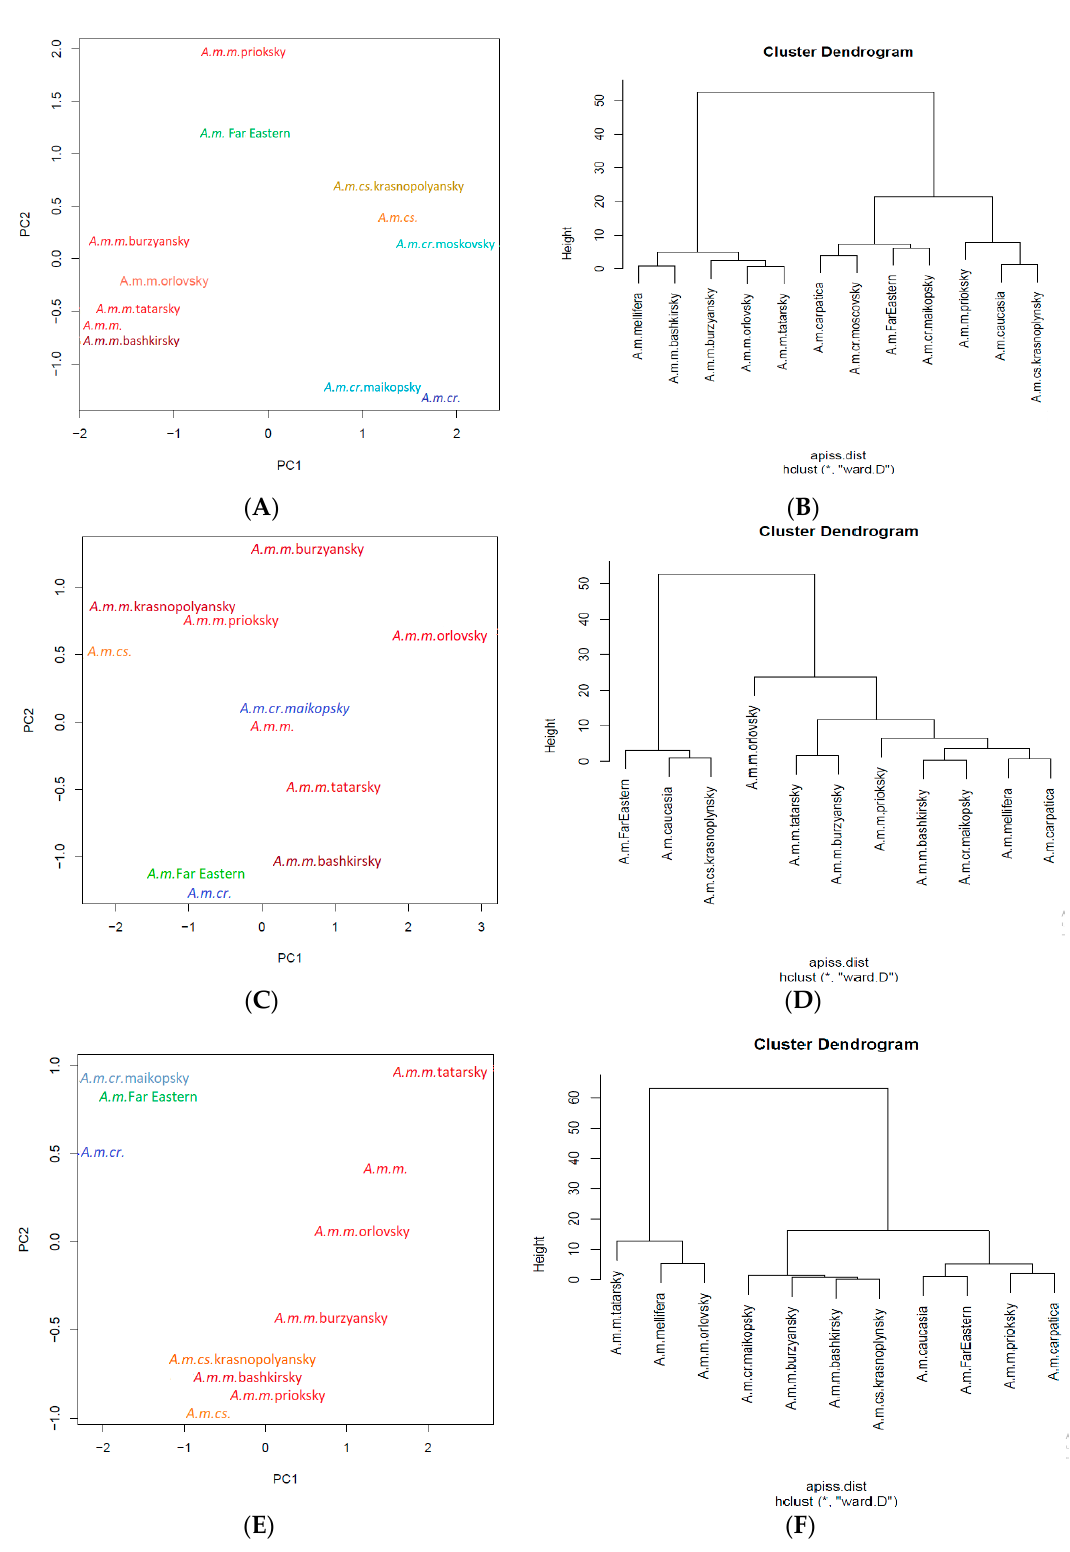
Figure 4. The classic morphometric discrimination between worker bees ( A , B ), queen bees ( C , D ), drones ( E , F ), and 12 types and